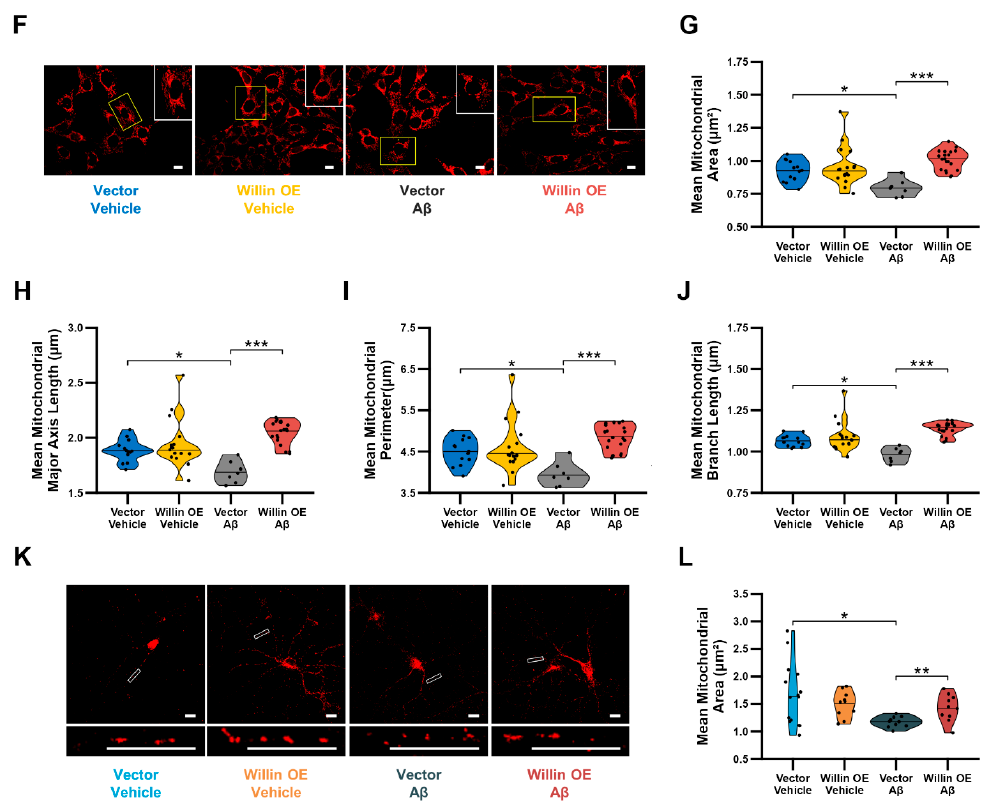
Figure 7. Overexpression of Willin/FRMD6 in mouse hippocampal HT-22 cells and primary mouse neurons attenuates A β -induced deficits in mitochondrial function and structure. ( A , B ) Primary hippocampal neurons were exposed to A β (0.5 µ M) for 48 h before measurement of mitochondrial reactive oxygen species by MitoSOX Red staining intensity. ( A ) Representative images of MitoSOX staining intensity in hippocampal neurons. Scale bar = 10 µ m. ( B ) Quantification of mitochondrial staining intensity for MitoSOX using NIH ImageJ, n = 6–9 FOV per condition with 1-5 neurons per FOV. Dots represent means per FOV. ** p < 0.01. ( C , D ) Mitochondrial redox capacity measured by MTT reduction assay in ( C ) cortical neurons and ( D ) HT-22 cells after 24 h treatment at the indicated A β concentrations. n = 3–6 per group. * p < 0.05. ns = not significant. ( E ) ATP levels in HT-22 cells were measured by luciferase assay following exposure to A β at the indicated concentrations for 24 h. n = 3 per group. * p < 0.05. ns = not significant. ( F – J ) HT-22 cells were exposed to A β (10 µ M) for 24 h before labeling with MitoTracker Red CMXRos for visualization of mitochondrial morphology. ( F ) Representative images of MitoTracker Red CMXRos staining in HT-22 cells. Scale bar = 10 µ m. Insets of regions of interest outlined in yellow shown in upper right corners. ( G – J ) Quantitative measurement of ( G ) mitochondrial area, ( H ) mitochondrial major axis length, ( I ) mitochondrial perimeter, and ( J ) mean mitochondrial branch length using MitoSegNet. n = 7–20 FOV per group with 10–50 cells per FOV. Dots represent means per FOV. * p < 0.05. *** p < 0.001. ( K , L ) Primary hippocampal neurons were exposed to A β (0.5 µ M) for 24 h prior to labeling with anti-TOM20 for visualization of mitochondrial morphology. ( K ) Representative images of TOM20 staining in hippocampal neurons in the indicated groups. Insets shown at the bottom. Scale bars = 10 µ m. ( L ) Quantification of mitochondrial area in neuronal processes using NIH Image J. n = 10–15 FOV per group with 23–334 mitochondria per FOV. Dots represent means per FOV. * p < 0.05. ** p <